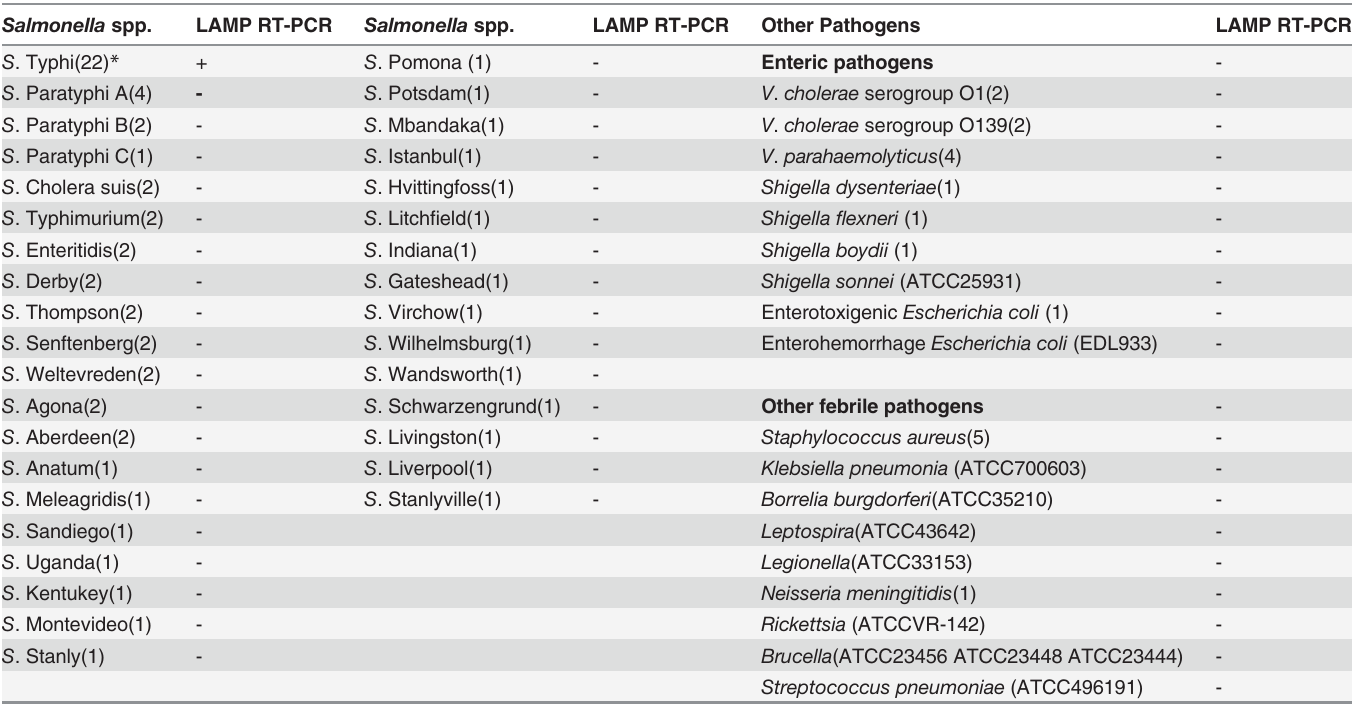
Table 1. Pathogenic strains used in the STY2879-LAMP assay. Salmonella